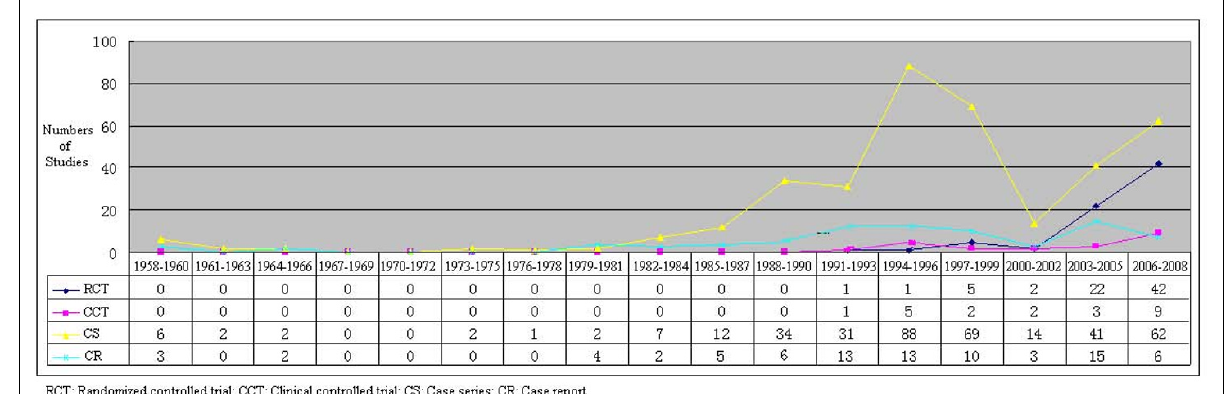
Figure 2 Numbers of studies on cupping therapy by study type between 1958 and 2008.